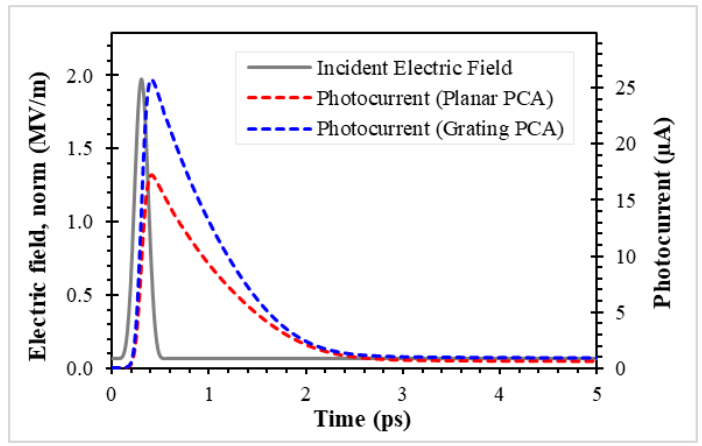
Figure 4. The probed electric field norm at the center of the excitation port (solid gray) and the induced currents generated at the terminal of the planar (dashed blue) and grating (dashed red) PCAs.